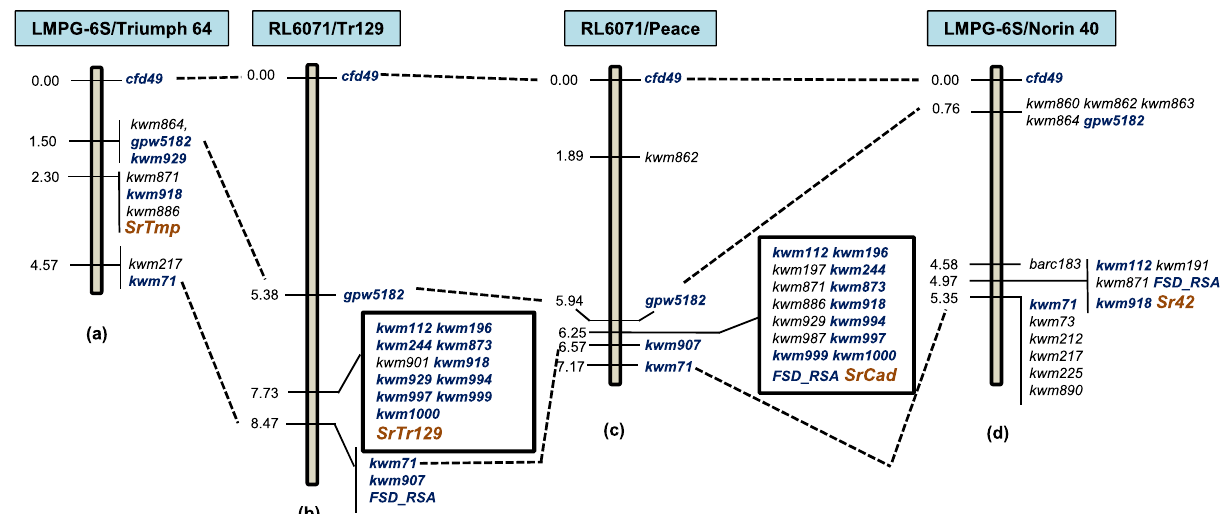
Figure 1. Comparison of the SrCad genomic region in four mapping populations: LMPG-6S/Triumph 64 ( a ), RL6071/Tr129 ( b ), RL6071/Peace ( c ), and LMPG-6S/Norin 40 ( d ). Markers shown in dark blue font were mapped in more than one mapping population and resistance genes are shown in dark orange font . Mapping distances are in centimorgans (cM).